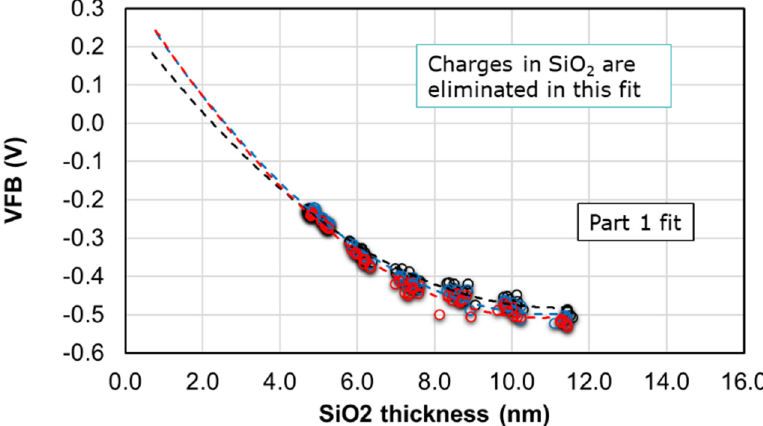
Figure 6. The V FB measured from CV is plotted as a function of SiO 2 thickness. A second order fit is performed to isolate the terms p and q containing the charge densities in its bulk and